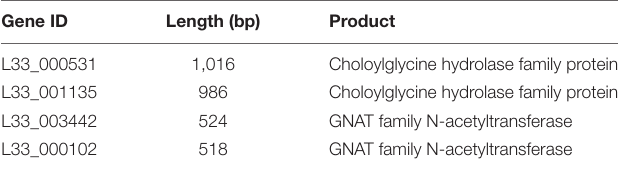
TABLE 2 | List of bile salt resistance genes identified in L. pentosus L33.